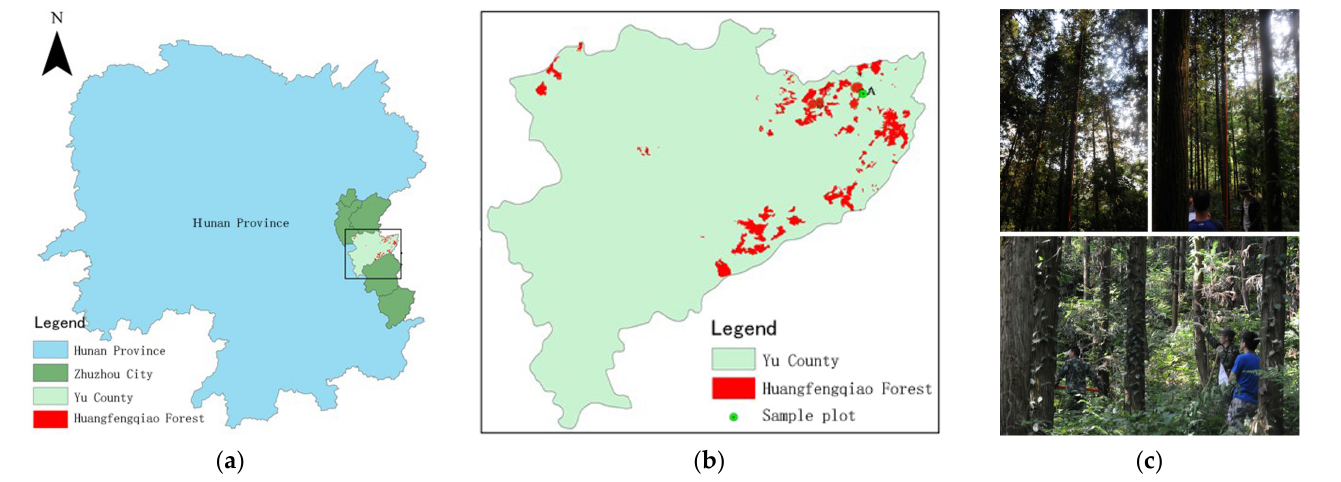
Figure 1. Description of study area: ( a ) Location of study area in Hunan Province. ( b ) Enlargement of inset in ( a ) showing details of the Huangfengqiao Forest and the sample area localization in Yu Country. ( c ) Example of the vegetation structure with forest canopy aspects.